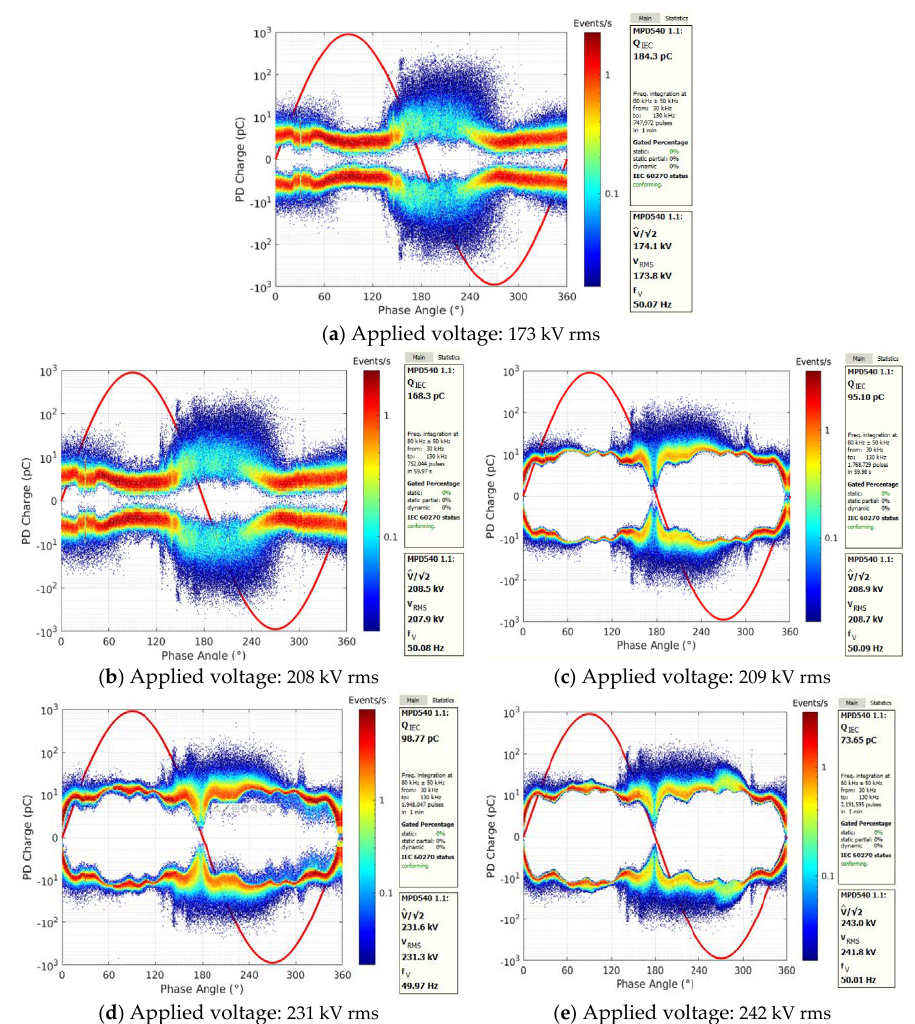
Figure 7. PD measurement of a gas insulated line demonstrator filled with 3 bar CO 2 —clean system— measured directly with a HV coupling capacitor for shown system rms voltages.